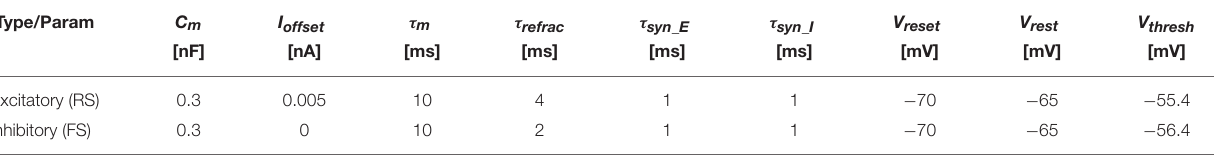
TABLE 1 | IfCurrExp Neuron model parameters for the PyNN simulation.